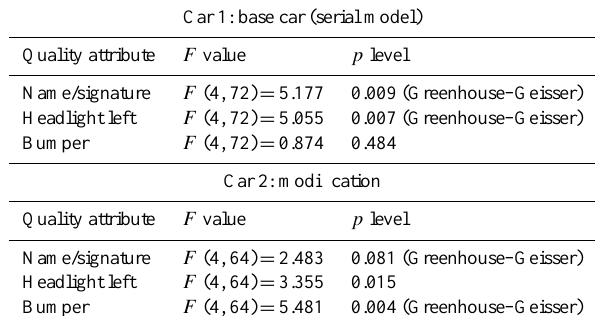
Table 3. Results for the selected quality attributes.